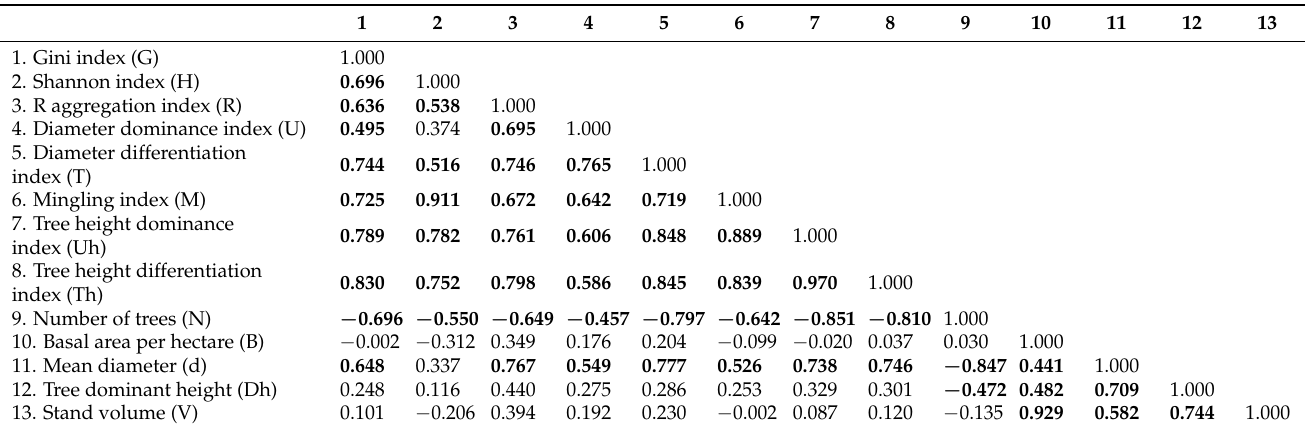
Table 2. Correlation coefficients (Spearman’s r ) between stand structural indices and stand structural parameters in the sweet chestnut forest. Associations that were statistically significant ( p < 0.05) are in bold.